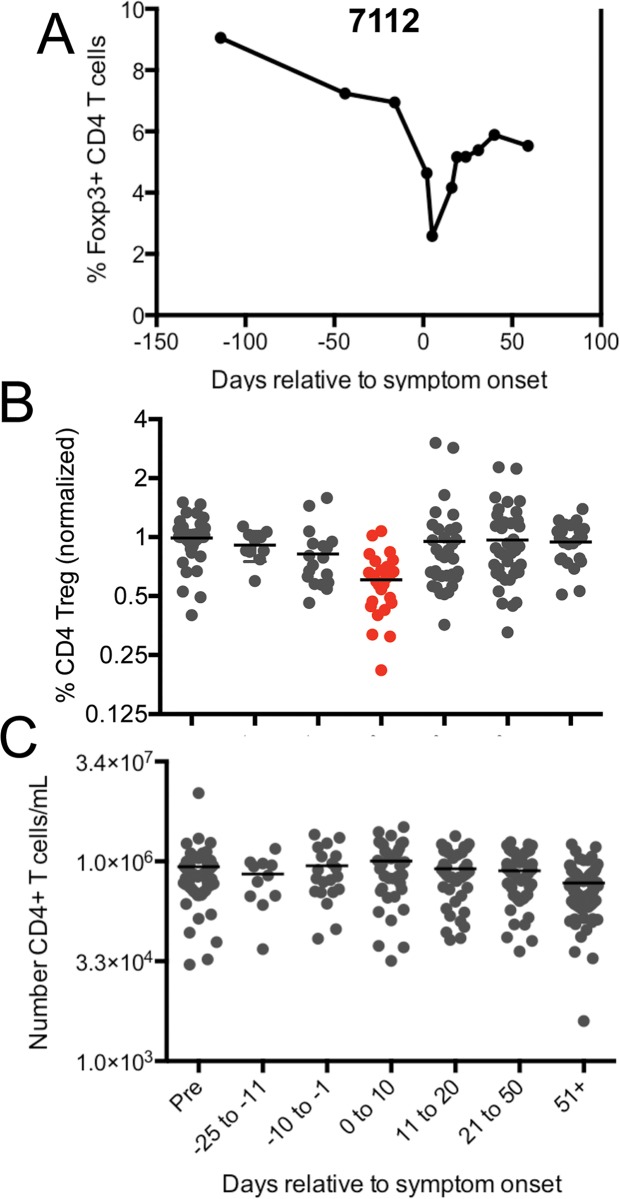
CD4+ Foxp3+ T cells transiently decline in the circulation at symptom onset during AIM.(A) Frequency of Foxp3+CD25+ cells amongst total CD4+ T cells data plotted over time for a representative individual (subject 7112). (B) Normalized frequency of Foxp3+ CD4 T cells over time in all subjects. Foxp3+ frequencies were normalized to each subject’s pre-infection baseline due to substantial variation in this population between individuals. (C) Number of CD4+ T cells per mL of whole blood over time. Statistics were performed using a one-way ANOVA with multiple test comparison. Gray values are not statistically different. Red value p<0.0001 compared to pre.